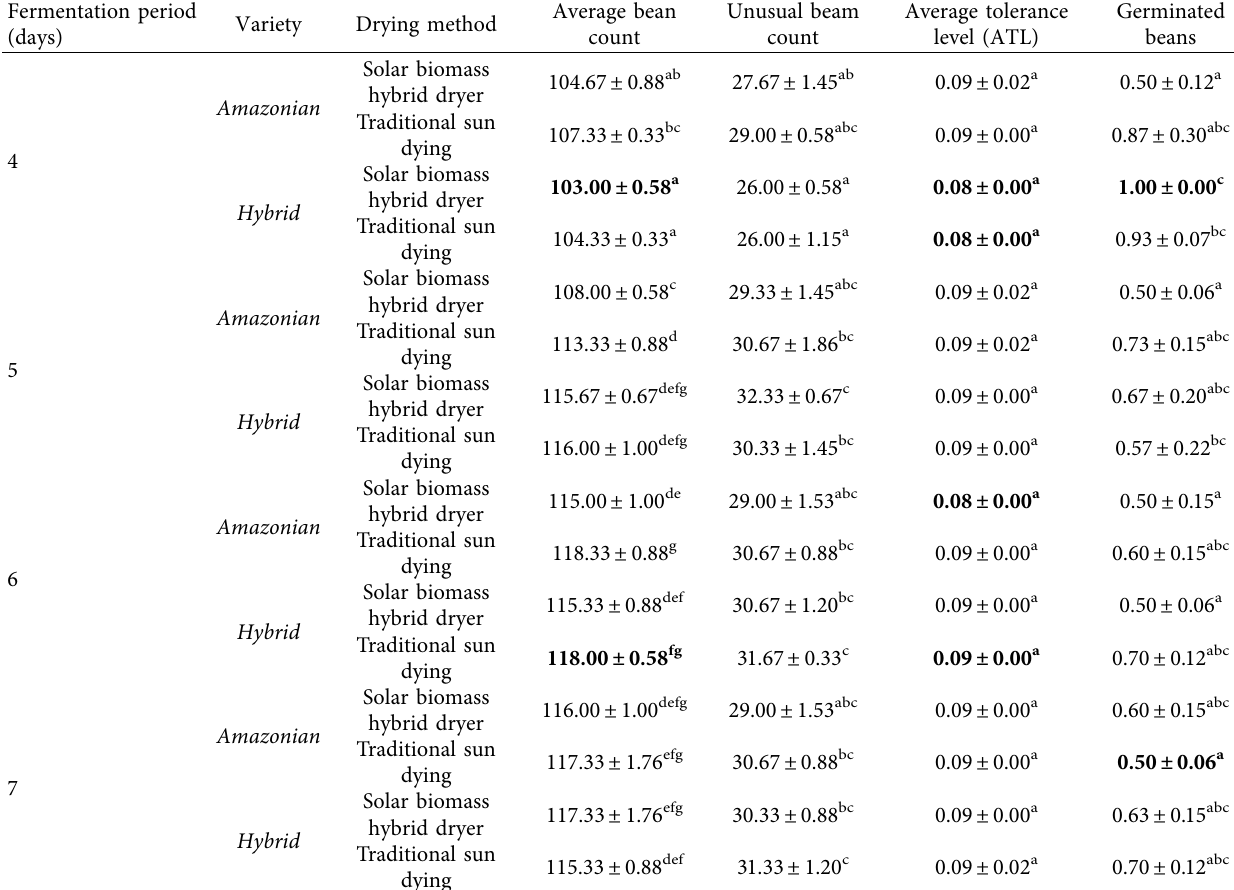
Table 2: Cut test properties of cocoa varieties under different fermentation and drying